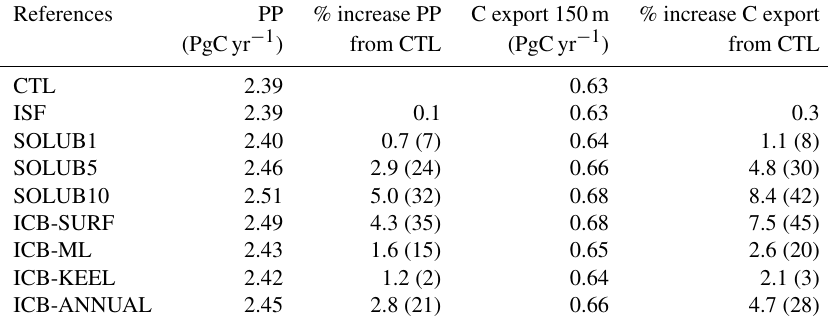
Table 3. Annual primary production integrated over depth (PP) and C export at a depth of 150m in the CTL experiment and in the AIS Fe source experiments over the Southern Ocean, south of 50 ◦ S. In brackets are the increases in PP and C export relative to the CTL experiment in the highly fertilized plume of the Atlantic sector, northeast of the Antarctic Peninsula (36–56 ◦ W, 58–63 ◦